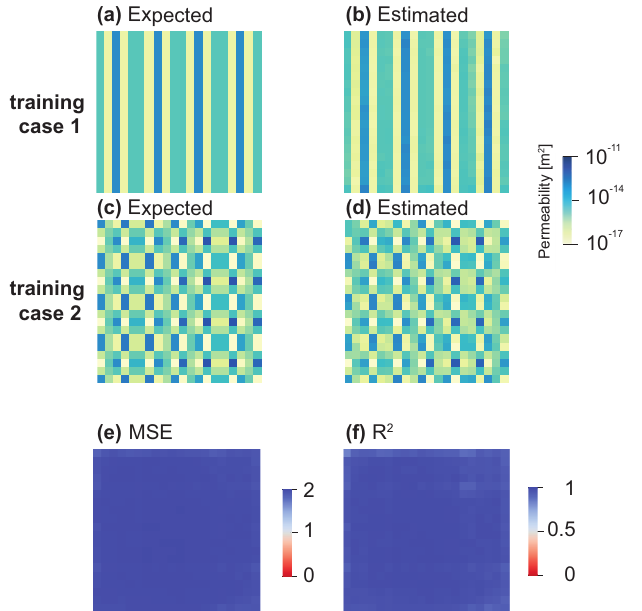
Figure 5. Results of permeability estimation for training dataset. Examples of ( a , c ) expected distribu- tions and ( b , d ) estimated results. Spatial error distributions with ( e ) MSE and ( f ) R 2 . Table 3. Scores for training and test datasets. * Represents the same conditions as the training datasets. Conditions Mass Flow Rate (kg/s) Position Score ( R 2 ) Training